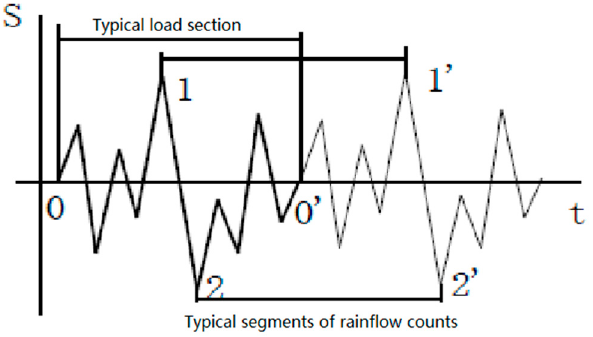
Figure 1. The selection of a typical section of rain-flow counting.